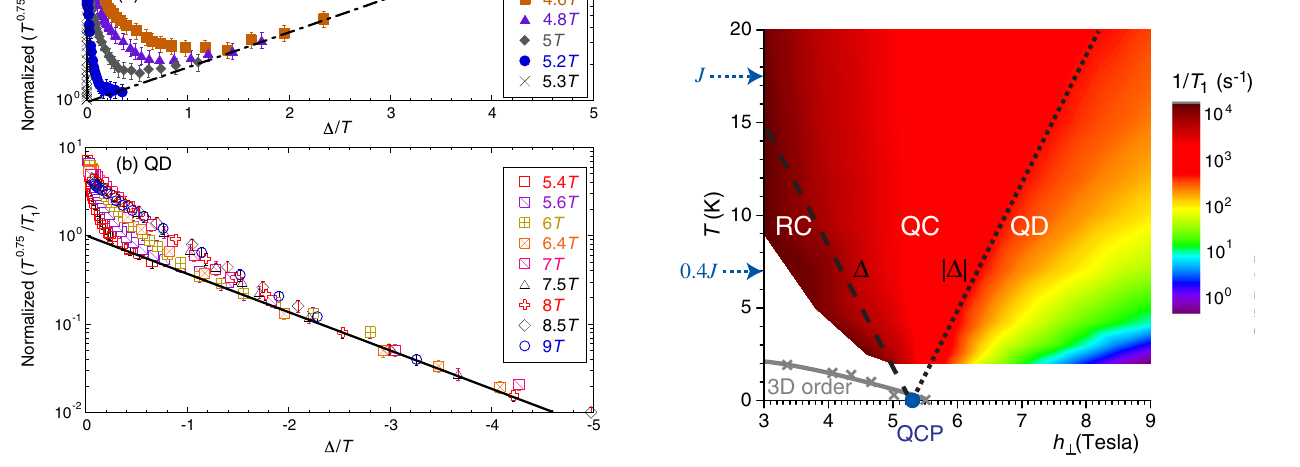
FIG. 9. A color plot of 1 =T 1 . The dashed (dotted) line represents the expected crossover temperature Δ ( j Δ j ) from the QC to the RC (QD) regime, based on the linear h ⊥ dependence of Δ estimated in Fig. 7(b). Also shown (grey x) is the 3D ordering temperature T 3 D c